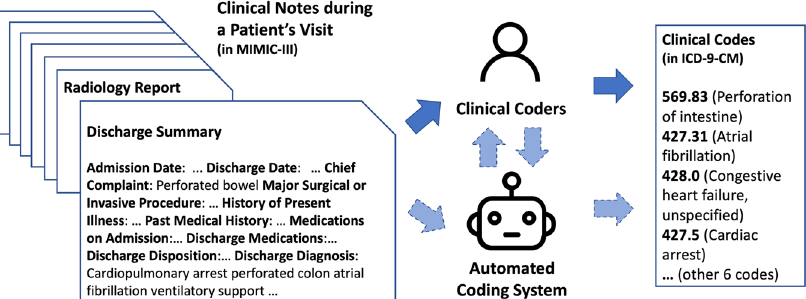
Fig. 1 An example of clinical coding, manual and automated (linked with solid and dashed arrows, respectively), with ICD-9-CM codes from a clinical note in the MIMIC-III data set 20 of ICU patients in 2001 – 2012 in a hospital in the US. Dashed arrows between clinical coders and the automated coding system suggest potential interactions between them, while this is yet to be considered in many clinical coding systems. Note that the format of data and clinical codes does not re fl ect the situation of other regions in the world — for example, in the UK, where data may be less structured and there is no universal discharge summary format